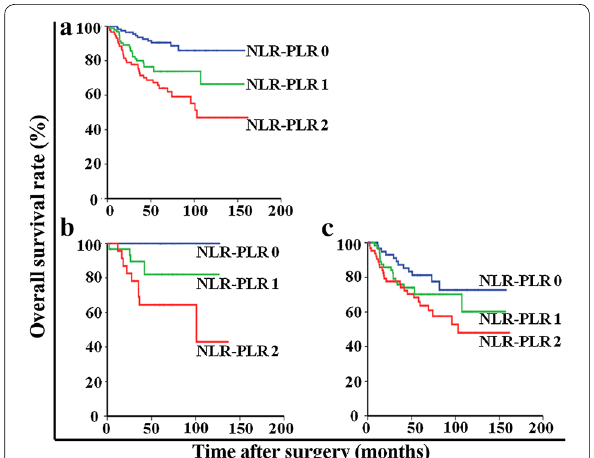
Fig. 2 Kaplan–Meier overall survival curves for the patients with stage I–II gastric cancer after curative resection. a patients with either stage I or II gastric cancer. b only patients with stage I gastric